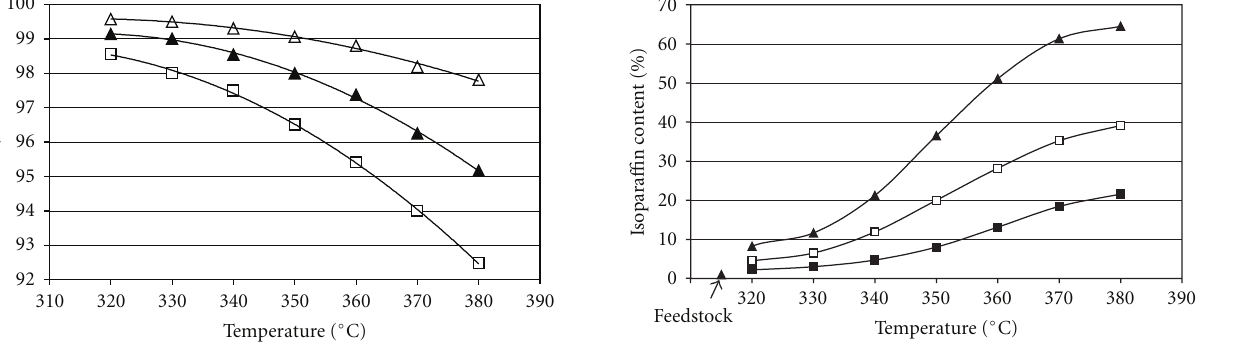
Figure 9: Product yields as a function of temperature and LHSV; -1.0h − 1 , -2.0 h − 1 and Δ -3.0h − 1 of LHSV ( P = 40bar, where: (cid:0) (cid:3) H 2 /hydrocarbon volume ratio = 400Nm 3 /m 3 ).